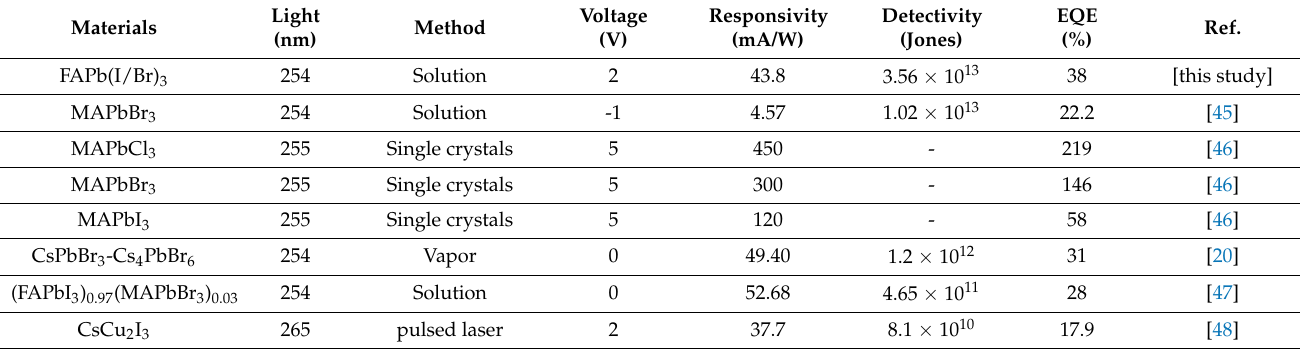
Table 2. Comparison of important parameters of various perovskite-based deep-UV